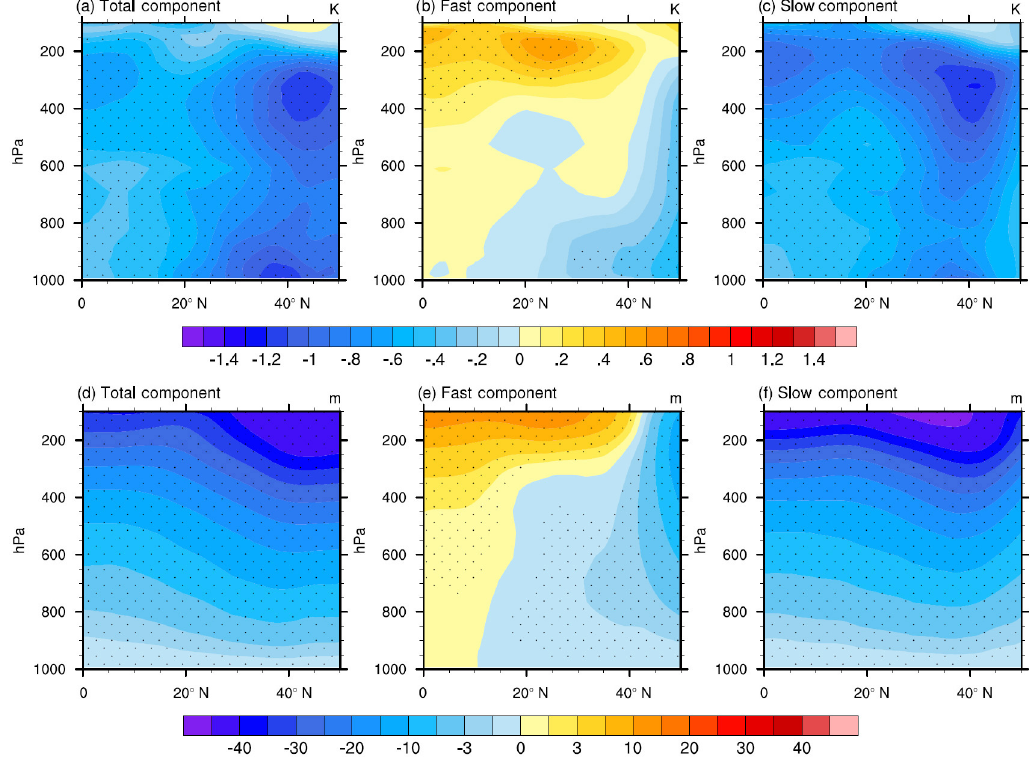
Figure 5. JJA mean total, fast, and slow responses of zonally averaged (a, b, c) atmospheric temperature (unit: K) and (d, e, f) geopotential height (unit: m) between 100 and 140 ◦ E to SO 4 forcing. The dots represent significance at ≥ 95% confidence level from the t test.